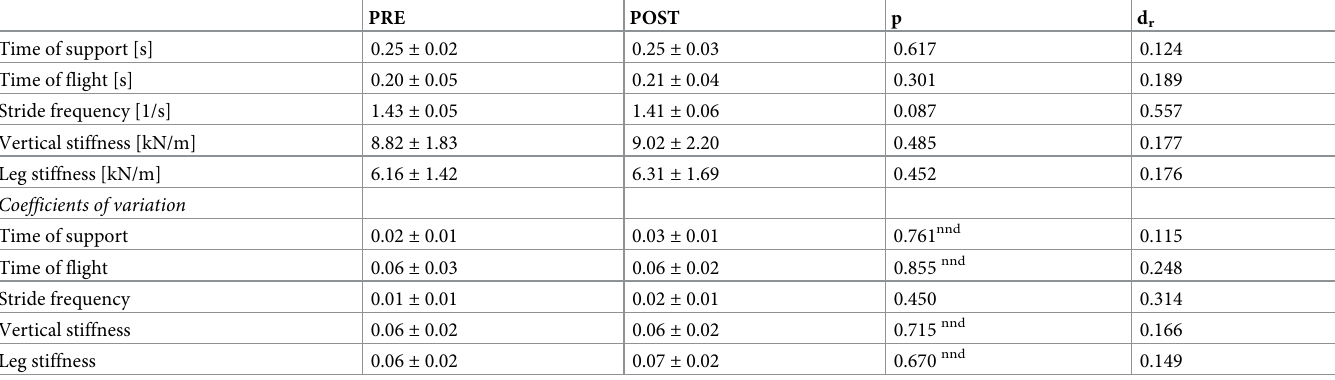
p-values as calculated by the paired t-tests and effect sizes are given. d r values of 0.2–0.50, 0.5–0.8 and > 0.8 indicate small, medium and large effects, respectively. A superscript “nnd” behind the p-value signifies a non-normal